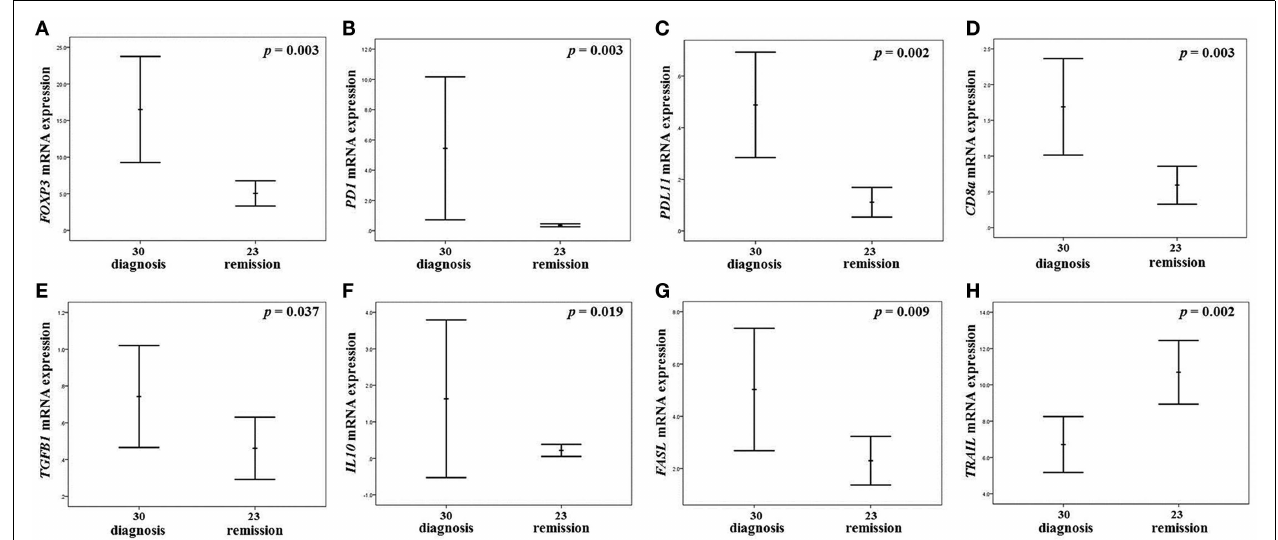
on-treatment long-term remission as compared to CHB patients at diagnosis. The charts describe the algorithms for error bar computation of the mean ± 2 standard errors for the relative expression of each gene. p -Values in each diagram refers to Mann–Whitney U test.